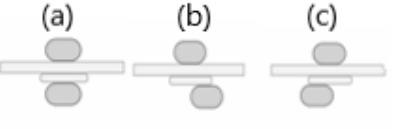
Figure 4. The experimental designs—( a ) centered, ( b ) shifted-left, ( c ) shifted-right. In each design the long rectangular object is the aluminum observation plate, the small rectangular object is the medium to test, and the dark gray ovals are the